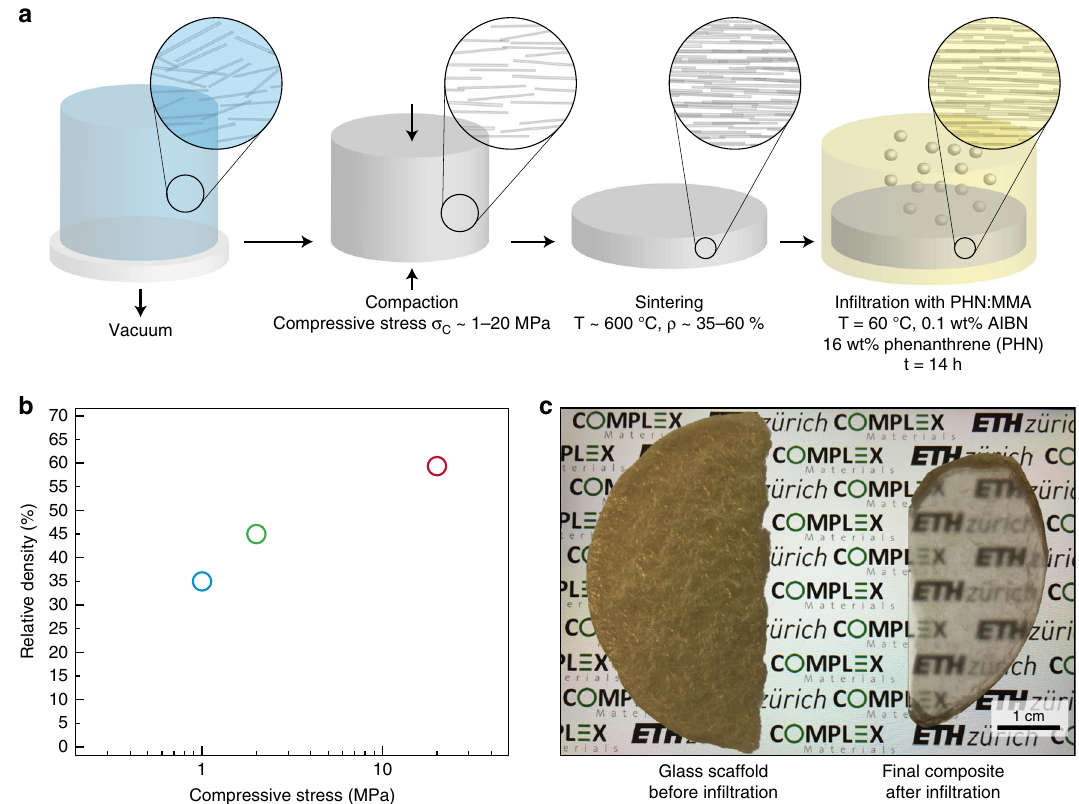
Fig. 1 Overview of the transparent nacre-like composites. a Flow chart illustrating the preparation of transparent nacre-like composites. b Relative density of the fi nal scaffolds after uniaxial compaction and sintering at 600 °C. Blue, green, and red symbols correspond to 35, 45, and 59% relative density, respectively. c Effect of the in fi ltration of a refractive-index matching polymer in a porous glass scaffold (left), resulting in a 2-mm-thick bioinspired transparent composite (right). Picture taken from a sample placed on top of a smartphone screen